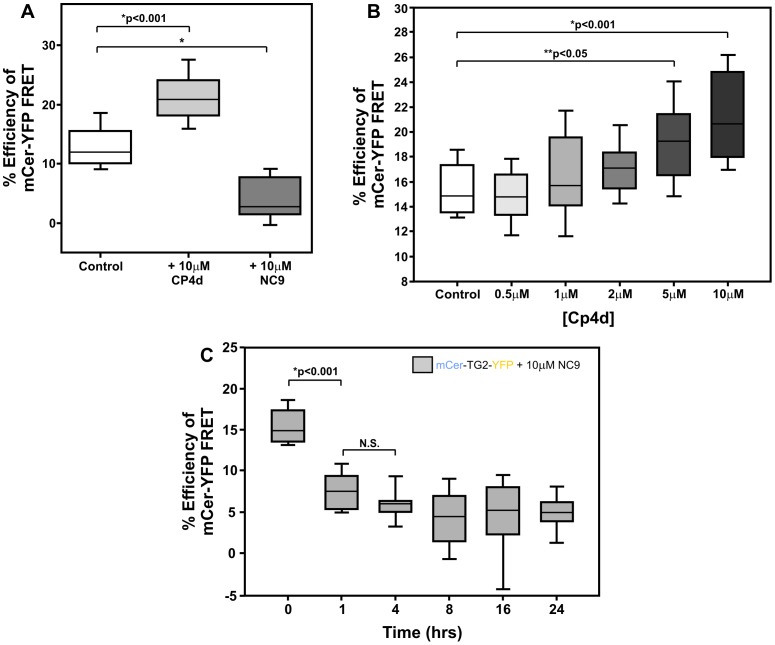
TG2 Inhibitors Differentially Affect TG2 Conformation.(A) Quantitative FLIM-FRET data shown as percent efficiency of FRET for the mCerulean-TG2-eYFP FRET sensor after a 16 hour treatment with either the irreversible TG2 inhibitor, NC9, or the reversible TG2 inhibitor, CP4d. (B) Percent efficiency of FRET graph generated following treatment of TG2 sensor with 5 increasing concentrations of CP4d. (C) Percent efficiency of FRET graph for TG2 sensor following treatment with 10 µM NC9 for 5 different time points from 0 to 24 hours. Black line represents median values, boxes encompass 25% and 75% confidence intervals and whiskers indicate the 5% to 95% confidence intervals. *p<0.001, **p<0.05 and N.S = not significant. N>10 for 4 replicates.